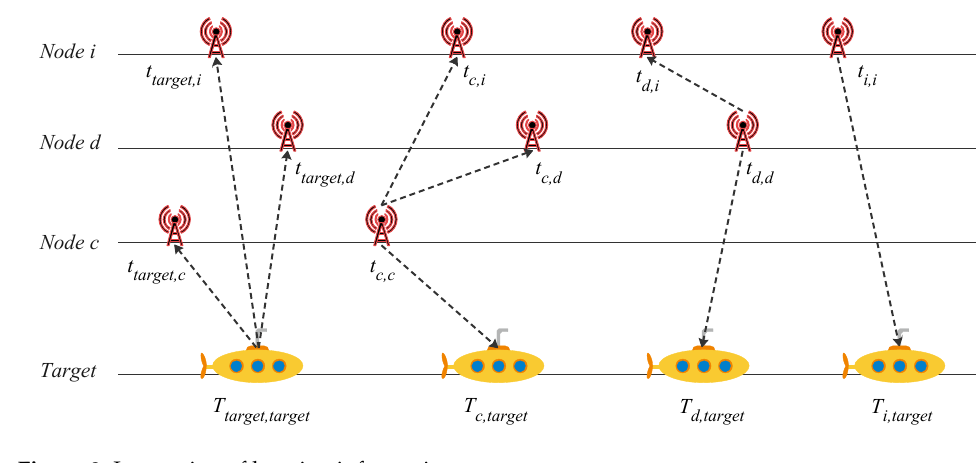
Figure 8. Interaction of location information